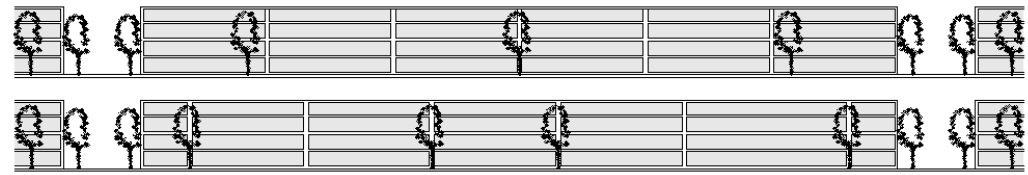
Figure 5. The configuration of trees—T1 scenario (upper—the east–west oriented canyon; lower—the north–south oriented canyon).